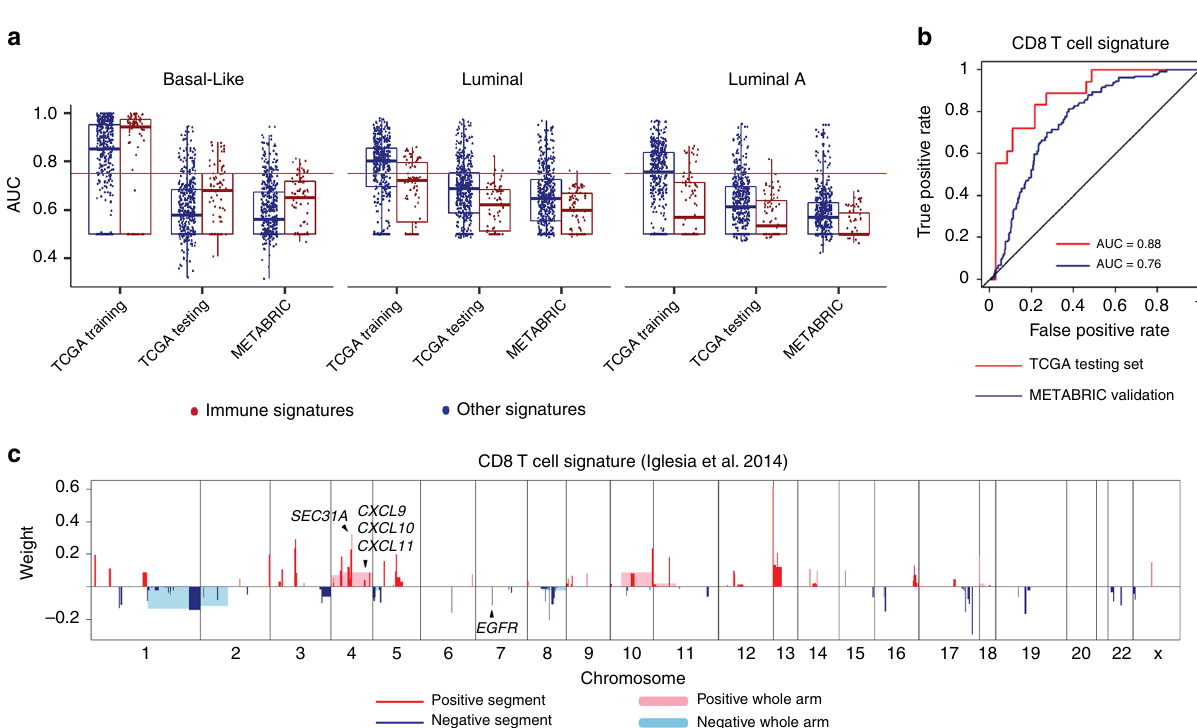
Fig. 5 Intrinsic subtype-speci fi c CNA-based Elastic Net models in breast cancer. a Box and whisker plots indicating the median score (horizontal line), the interquartile range (IQR, box boundaries) and 1.5 times the IQR (whiskers) of AUC values for predicting gene signatures within Basal-like (n = 185), Luminal ( n = 853) and Luminal A ( n = 556) samples; note that the plots are strati fi ed into immune signatures ( n = 78) and other signatures ( n = 465). The red horizontal line indicates AUC = 0.75. b ROC curves and corresponding AUC values of TCGA test set and METABRIC validation set for predicting CD8 T cell expression signature within Basal-like samples. c Selected CNA segments and/or whole chromosomal arms and their coef fi cients of prediction model for CD8 T cell expression signature within Basal-like